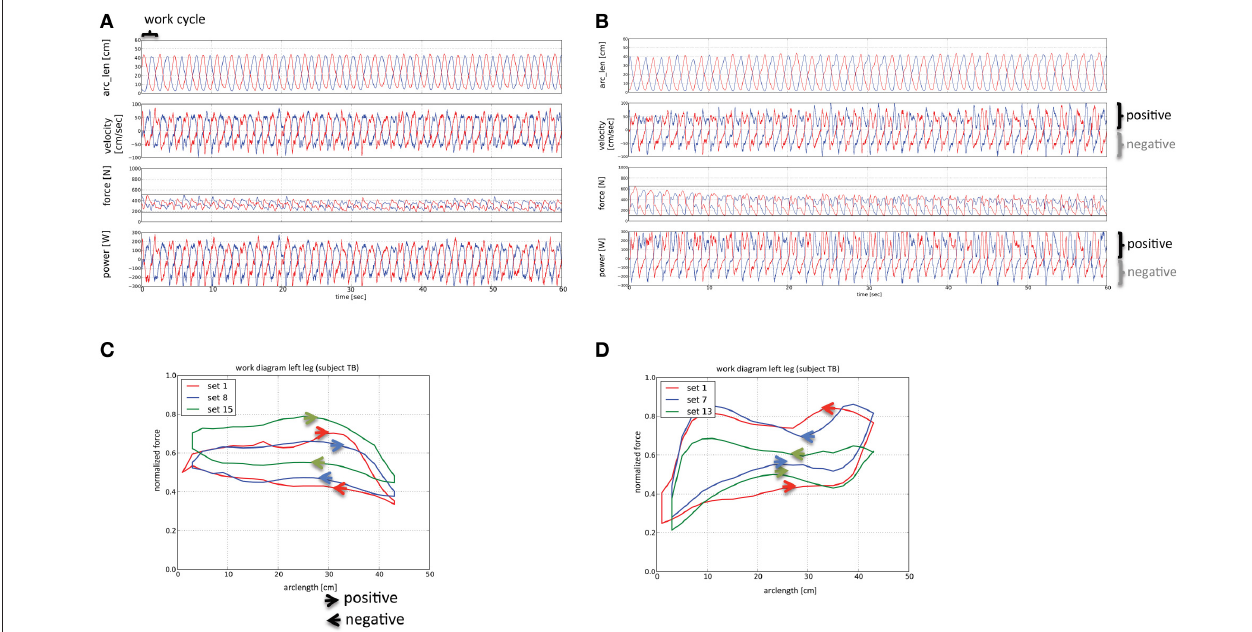
FIGURE 2 | Work diagrams of the interval-types of concentric and eccentric exercise. Line graphs visualizing the sampled mechanical characteristics during 30 work cycles of each leg within one set of the concentric (A) and eccentric (B) interval exercise on the soft robot. Red and blue lines symbolize the measured parameters for the left (blue) and right leg (red). The length of a work cycle is indicated with a swung bracket (top left in panel A ). The zones corresponding to the phases where positive and negative work is developed are indicated. Values for power, force, velocity and arc length (arc_len) are shown. Note a considerable portion of the power is produced points in the negative direction for the concentric protocol, and the positive direction for the eccentric protocol, respectively. (C,D) Line graphs visualizing the average of normalized force output in different sets of the interval-type of concentric (C) and eccentric exercise (D) . The direction in which work is performed is indicated with arrowheads. The inspection of the force: length relationships in (C,D) of the same representative subject reveals the average contribution of positive and negative force production at different arc length, and differences between sets, to the work cycle within an exercise protocol. For instance, (C) shows that force transits from nearly constant and higher levels in the extension phase to lower and equally constant values at the largest arc length (when legs become fully extended) in the flexion phase during the concentric interval exercise. In consequence, eccentric force is developed during the concentric protocol of interval exercise. Note that in the last cycle of this protocol the force developed during, both, the eccentric and concentric phase is higher for the displayed subject. Conversely, in (D) showing the work cycle during the eccentric interval exercise, one can recognize that the developed forces are higher during the flexion compared to the extension phase. Thereby the forces developed in both phases are less regular and more distinct than for the concentric